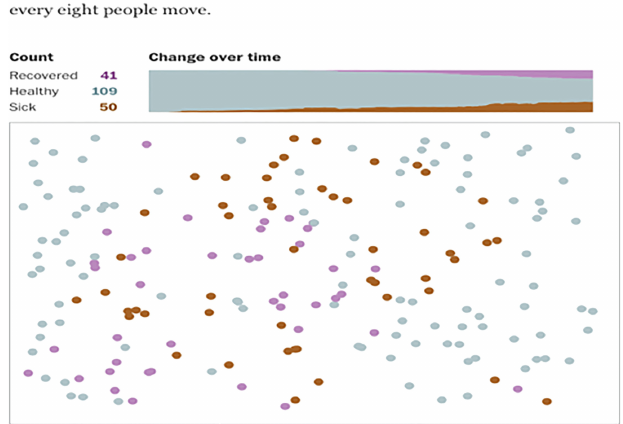
Figure 2. Simulation of